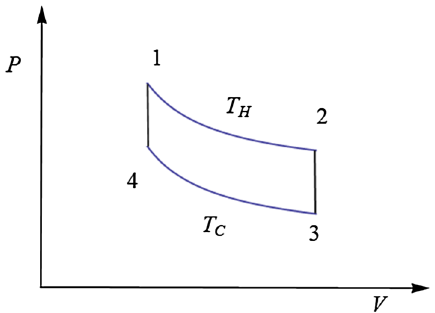
Fig. 2 Carnot engine